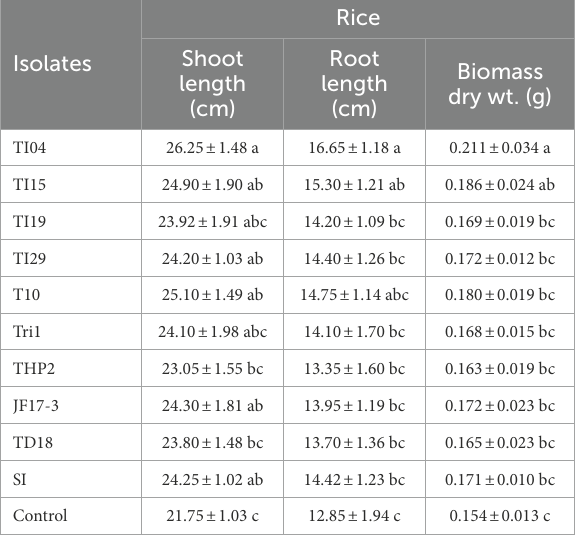
TABLE 2 The influence of Trichoderma isolates with SI on seedling growth of rice under greenhouse conditions.